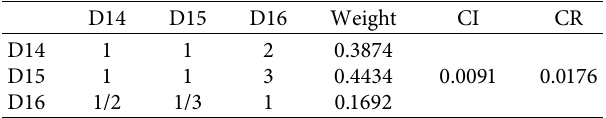
Table 7: Judgment matrix, weight distribution, and consistency test of environmental information accuracy.